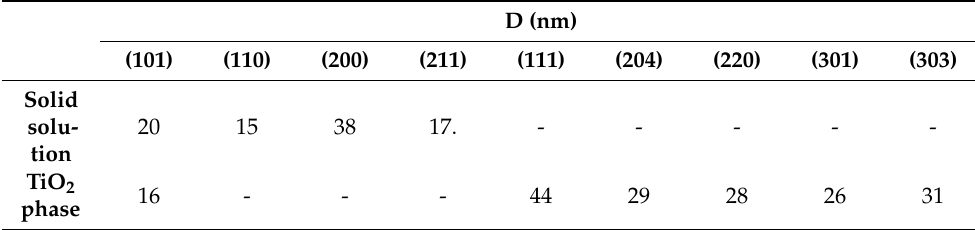
Table 1. Apparent size of the crystallite (D) obtained for the DSA ® Ti/RuO 2 -TiO 2 -SnO 2 (50:40:10 atom. %) electrode on different phases.